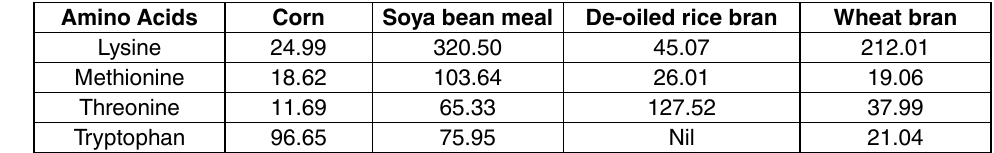
table 1. Amino acid contents in feed ingredients used for the trial (mg/kg) Amino